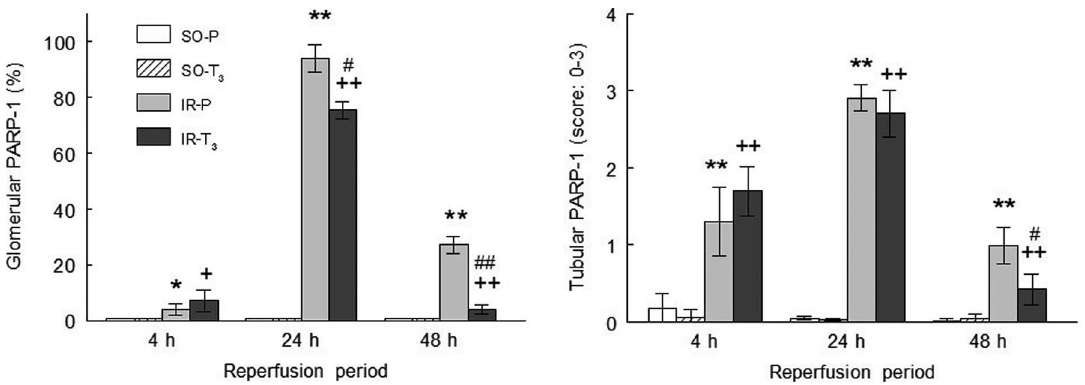
Figure 4. Glomerular (A) and tubular (B) expression of PARP-1 in the experimental groups. (n=10 each group): SO-P= sham-operated- placebo; SO-T